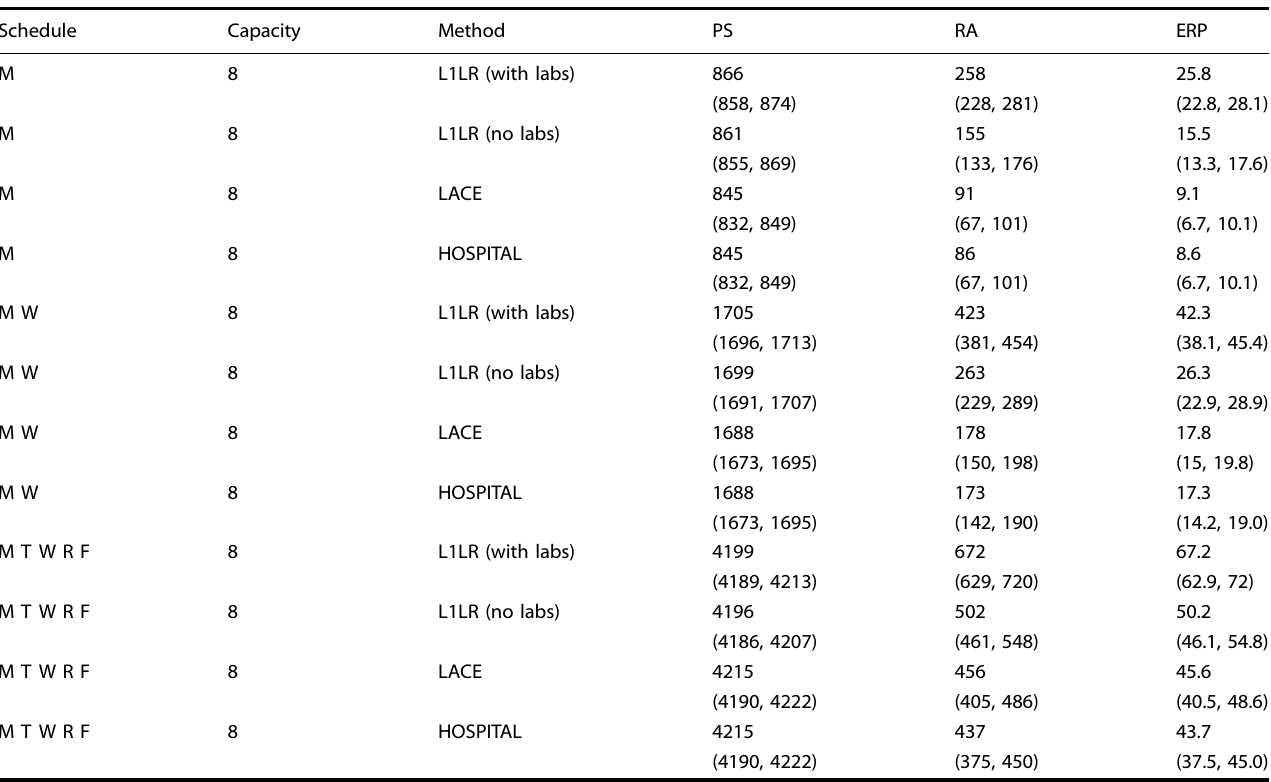
Table 2. Simulation-based patient performance metrics for the four models.